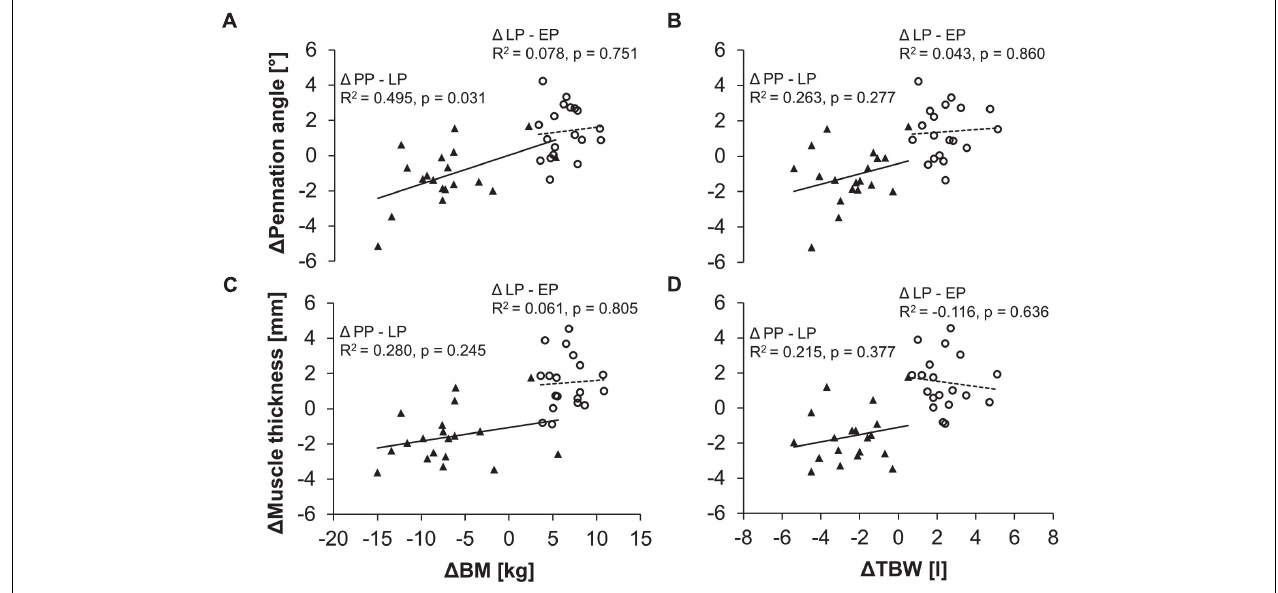
FIGURE 4 | Relationship between the changes in body mass (BM) and the changes in the pennation angle (A) or muscle thickness (C) as well as between the changes in the total body water (TBW) and the changes in the pennation angle (B) or muscle thickness (D) in the pregnant women. Demonstrated are the differences of the parameters between the early and late stage of pregnancy ( (cid:49) LP-EP, circles) as well as between the postpartum period and the late stage of pregnancy ( (cid:49) PP-LP, triangles) and the respective linear regression lines (dashed line for (cid:49) LP-EP, solid line for (cid:49)